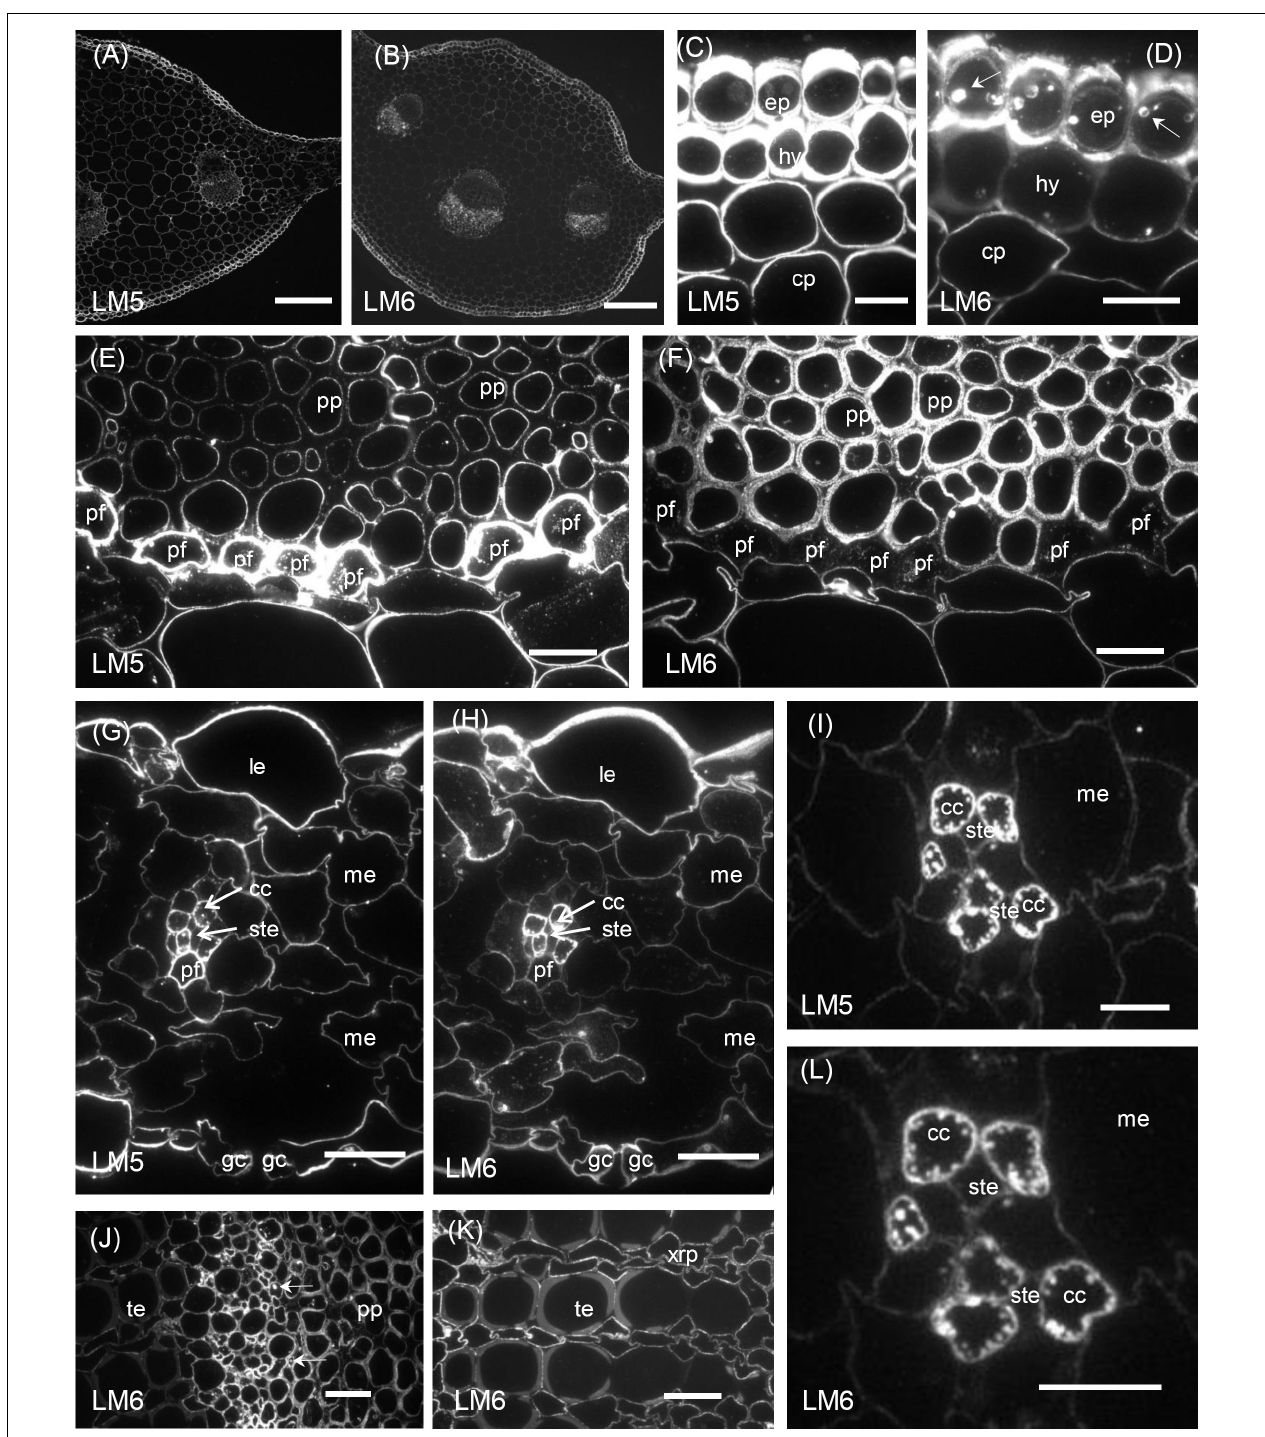
FIGURE 3 | Immunofluorescence micrographs of transverse sections cut from a rosette leaf of an 8-week-old chicory plant and labelled with LM5 or LM6. (A) The midrib labelled withLM5. (B) The midrib labelled with LM6. (C) The midrib labelled with LM5, showing very strong labelling on the epidermal and hypodermal walls and moderate labelling of the parenchyma cell walls. (D) The midrib labelled with LM6, showing the very strong labelling of the epidermal walls and the moderate labelling of the hypodermal and parenchymal cell walls. (E) The midrib labelled with LM5, showing very strong labelling of the phloem fibre walls and the inner walls of the phloem parenchyma cells. (F) The midrib labelled with LM6, showing strong labelling of the phloem parenchyma cell walls but not the middle lamellae between these cells and no labelling of the phloem fibre walls. (G) The lamina labelled with LM5, showing strong labelling of the epidermal cell walls and no labelling on